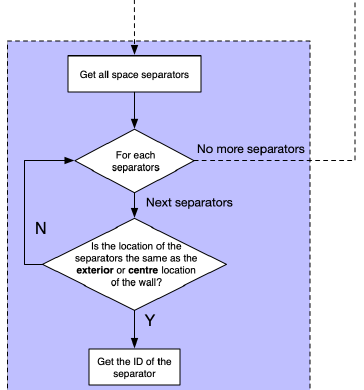
Figure 9. Deleting previous room